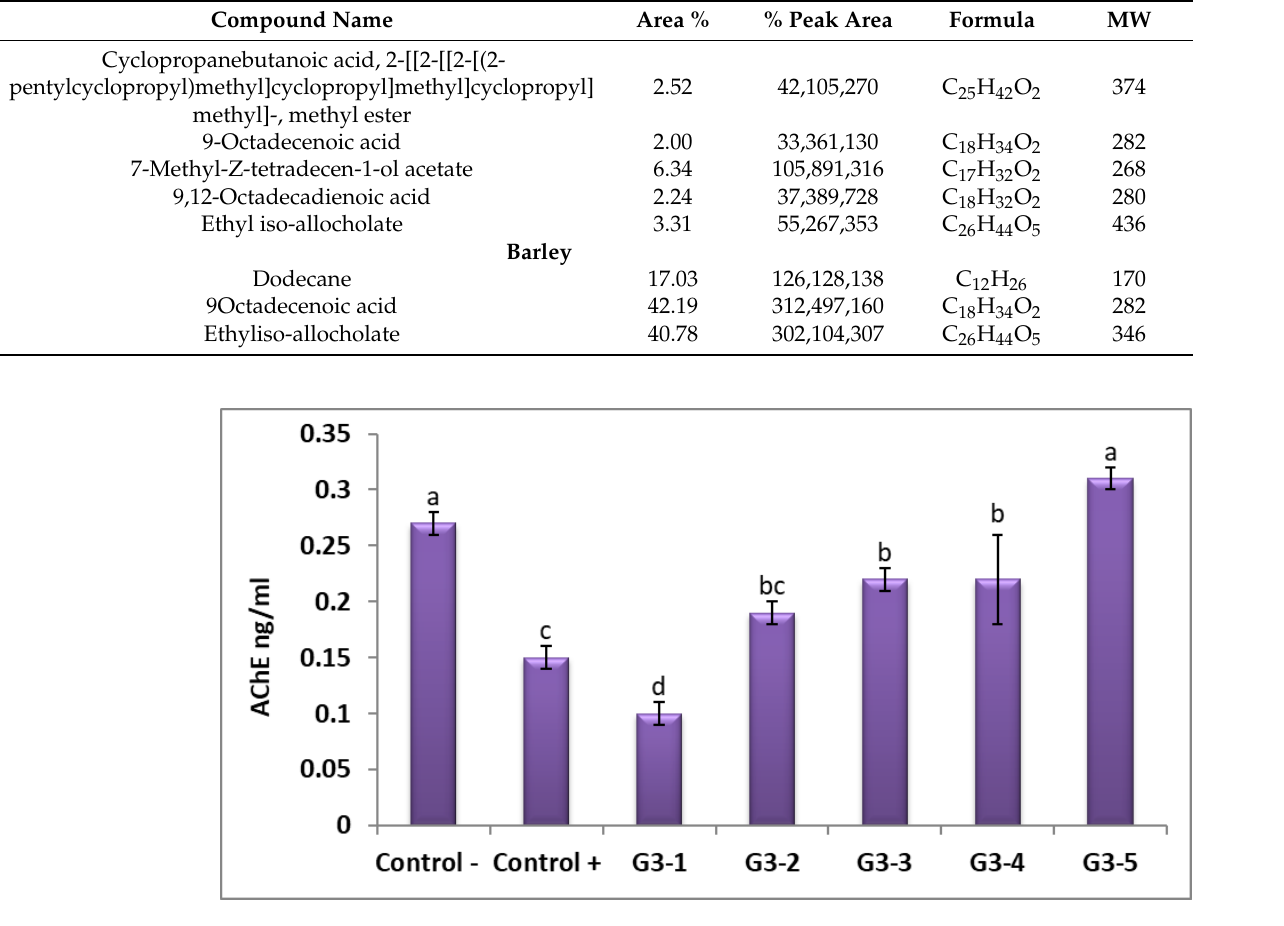
Figure 2. Acetylcholineesterase (AChE) level in rat brains.Values with different letters in each column showed a significant difference.